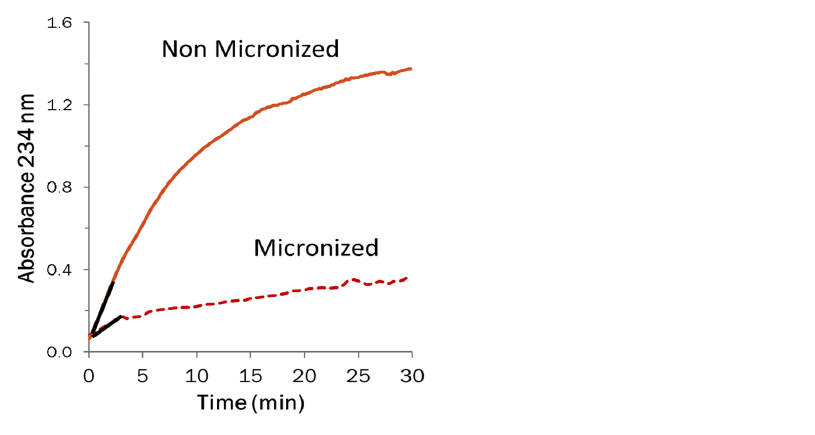
Figure 3. Effect of IR heating on lipoxygenase activity of lentil (one enzyme unit = ∆ in abs of Figure 3. E ff ect of IR heating on lipoxygenase activity of lentil (one enzyme unit = Δ in abs of 0.001/min). (Reprinted with permission from Der [16]). 0.001/min). (Reprinted with permission from Der